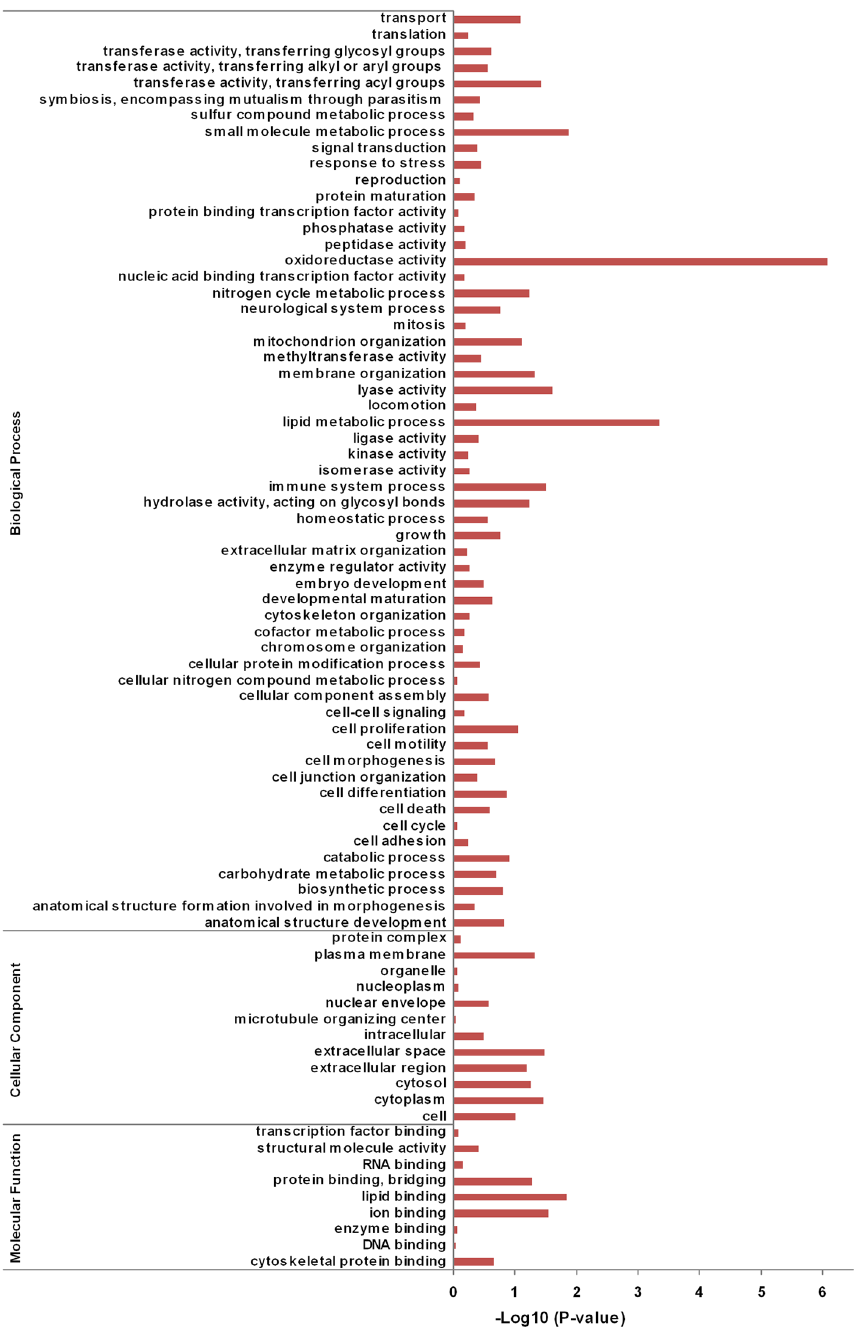
Figure 1. GO enrichment analysis of genes regulated by chGH in chicken hepatocytes. The GO terms are sorted by –Log10 of the enrichment P-value, which represents the enrichment significance of GO terms. The enrichment of GO terms is showed by comparing DEG with the whole genome from this figure.